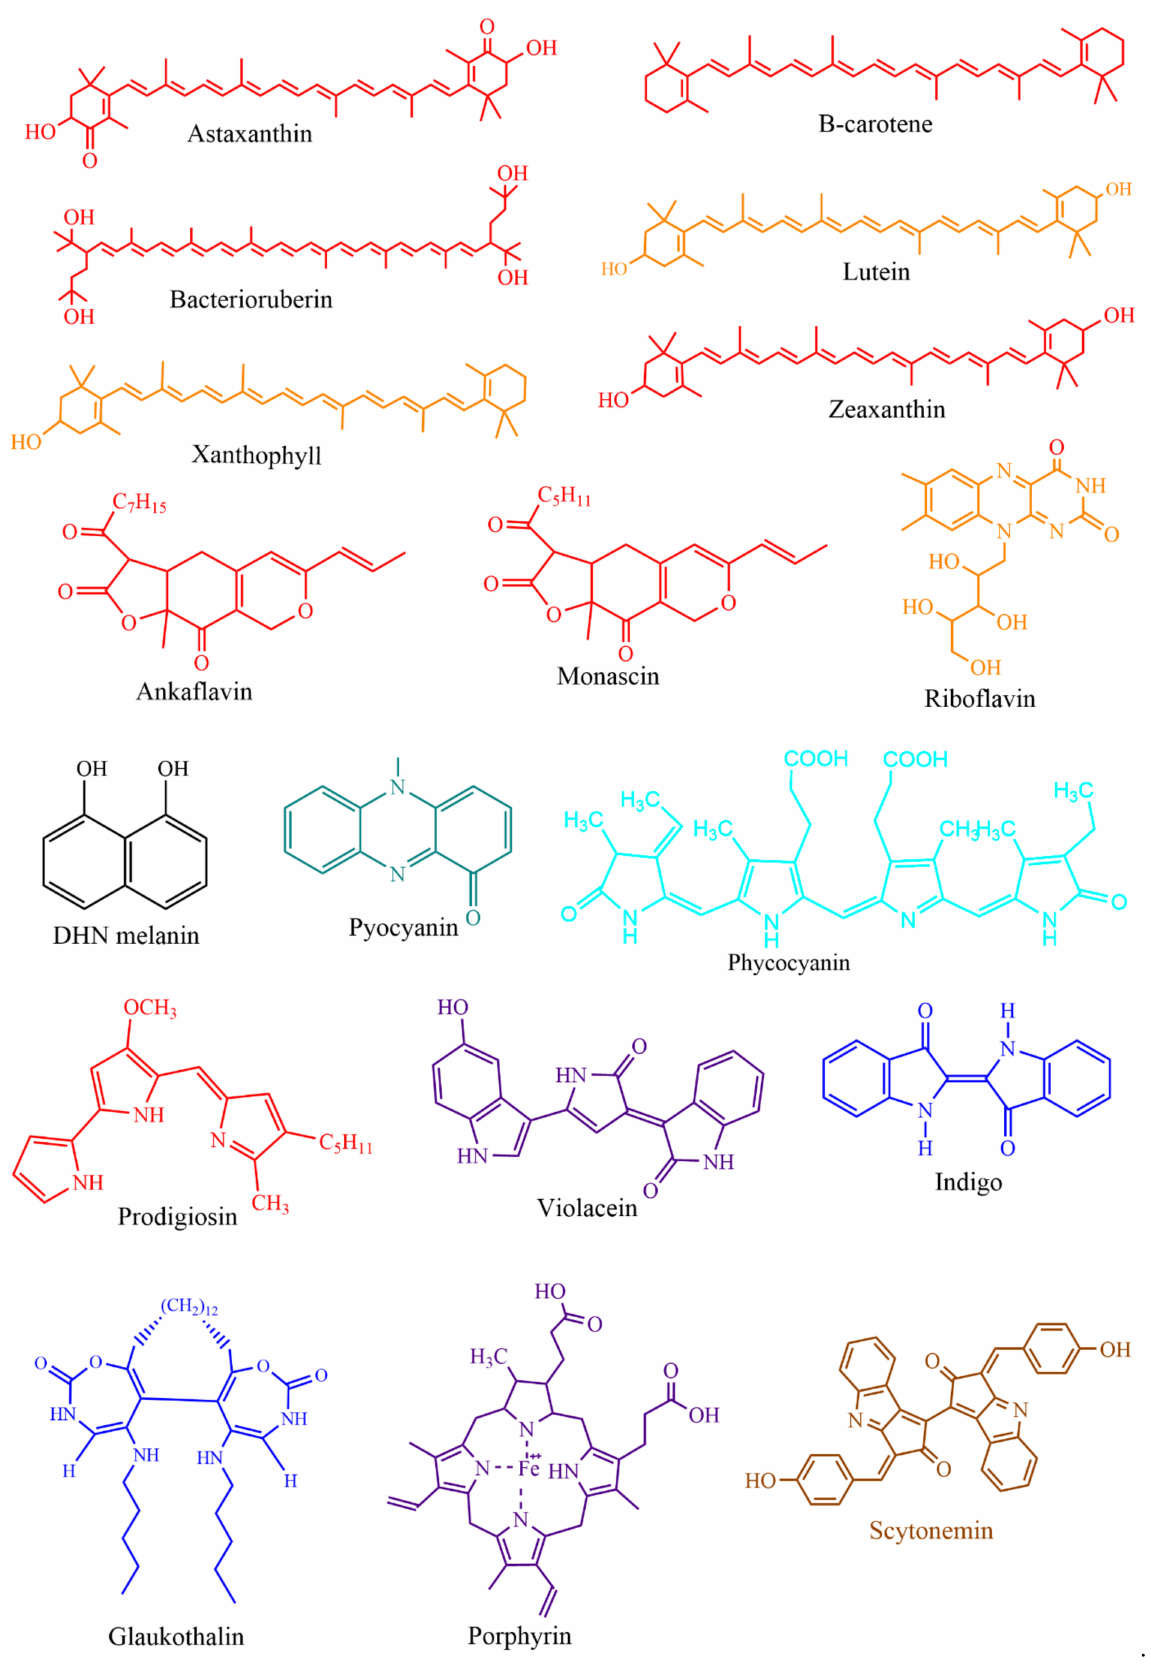
Figure 6. Chemical structures of important microbial